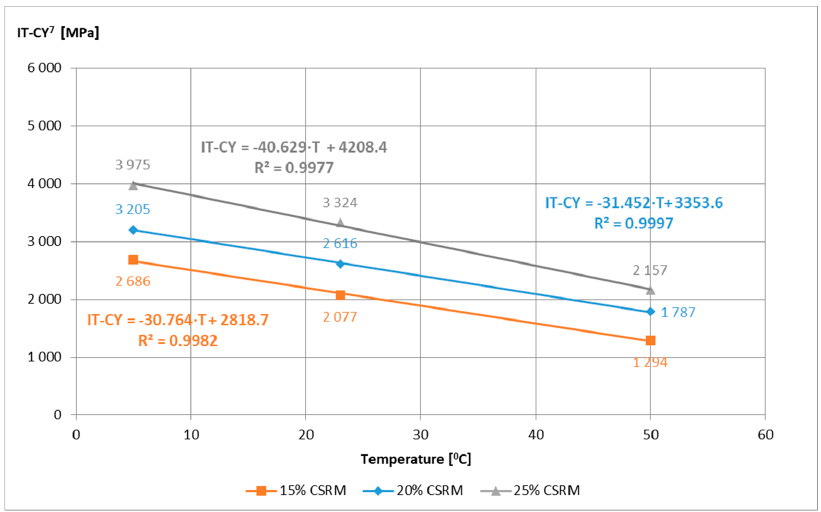
Figure 8. IT-CY stiffness modulus of ACCR with “B” CSR mortar samples Ø100 mm × 63.5 mm depending on the temperature, after 7 days of curing.